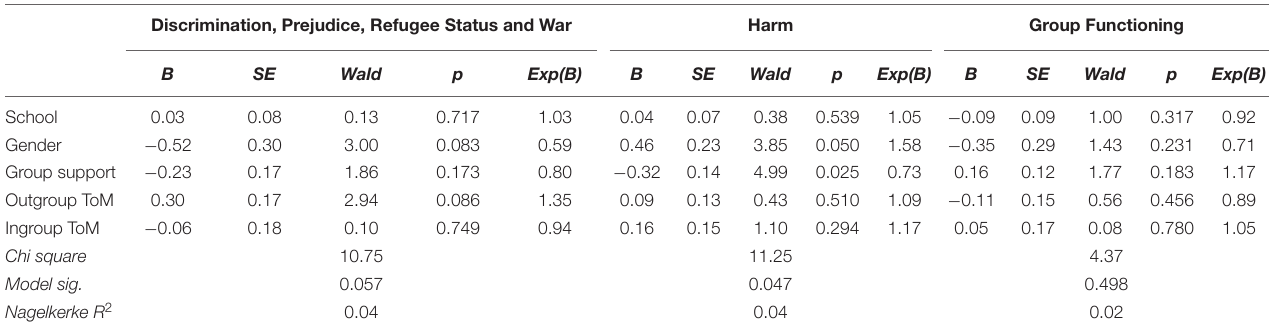
TABLE 5 | Binary logistic regression analyses for reasoning of group support to intergroup bullying. Discrimination, Prejudice, Refugee Status and War